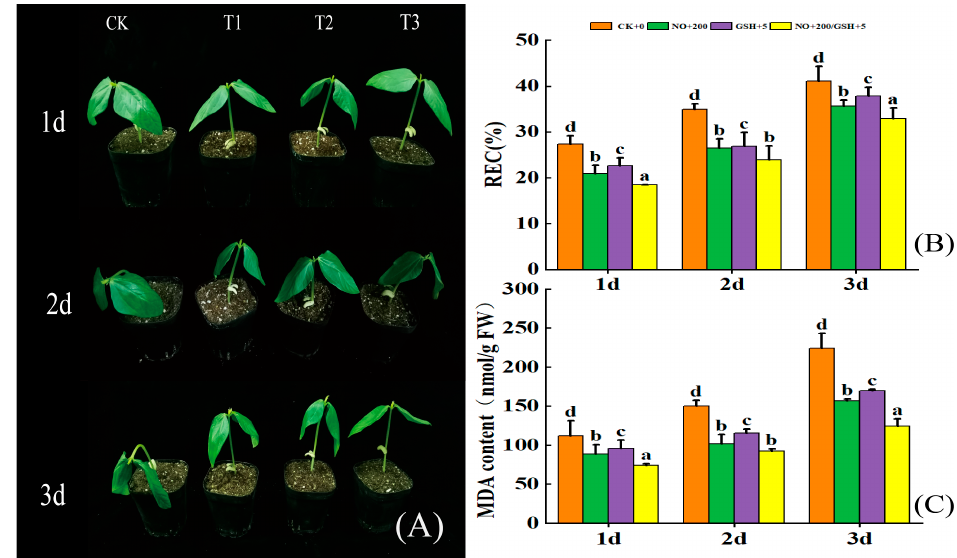
Figure 1. Effects of low-temperature stress on phenotype ( A ) (CK: low-temperature clear-water control, T1: 200 μ mol/L NO, T2: 5 mmol/L GSH, T3: 200 μ mol/L NO + 5 mmol/L GSH) and physiological indices ( B , C ) of cowpea seedlings. Different letters indicate statistically significant differences according to Duncan’s multiple range test p ≤ 0.05.